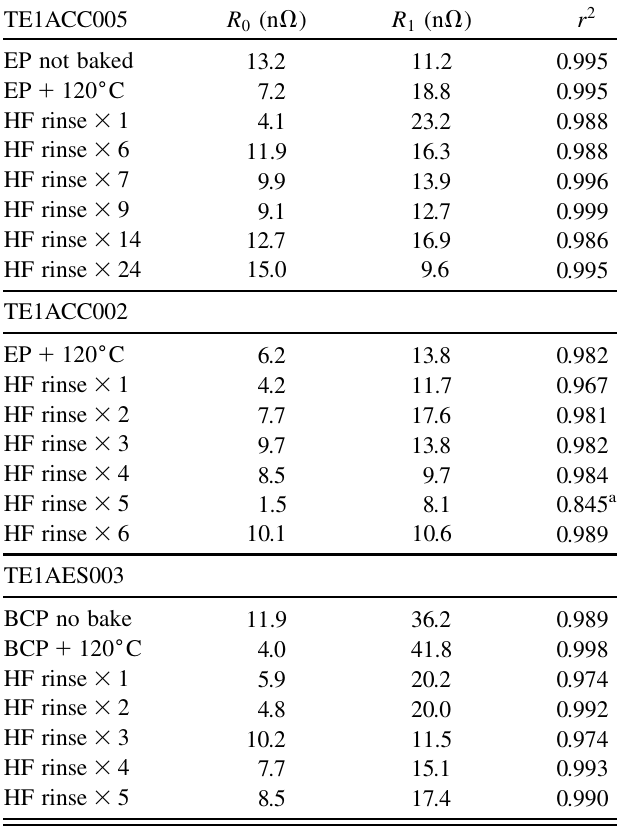
Fig. 9. After six HF rinses ( (cid:4) 9 – 12 nm of niobium con-